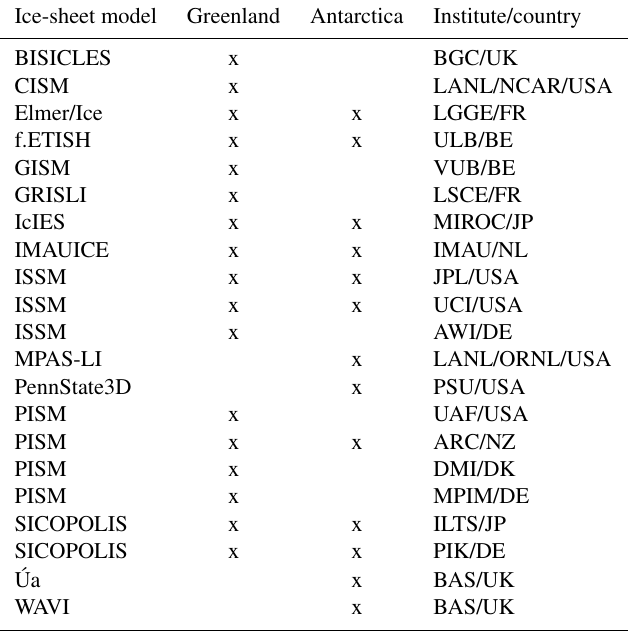
Table 4. Ice-sheet modeling groups that have expressed an interest in ISMIP6. x indicates a planned contribution. Ice-sheet